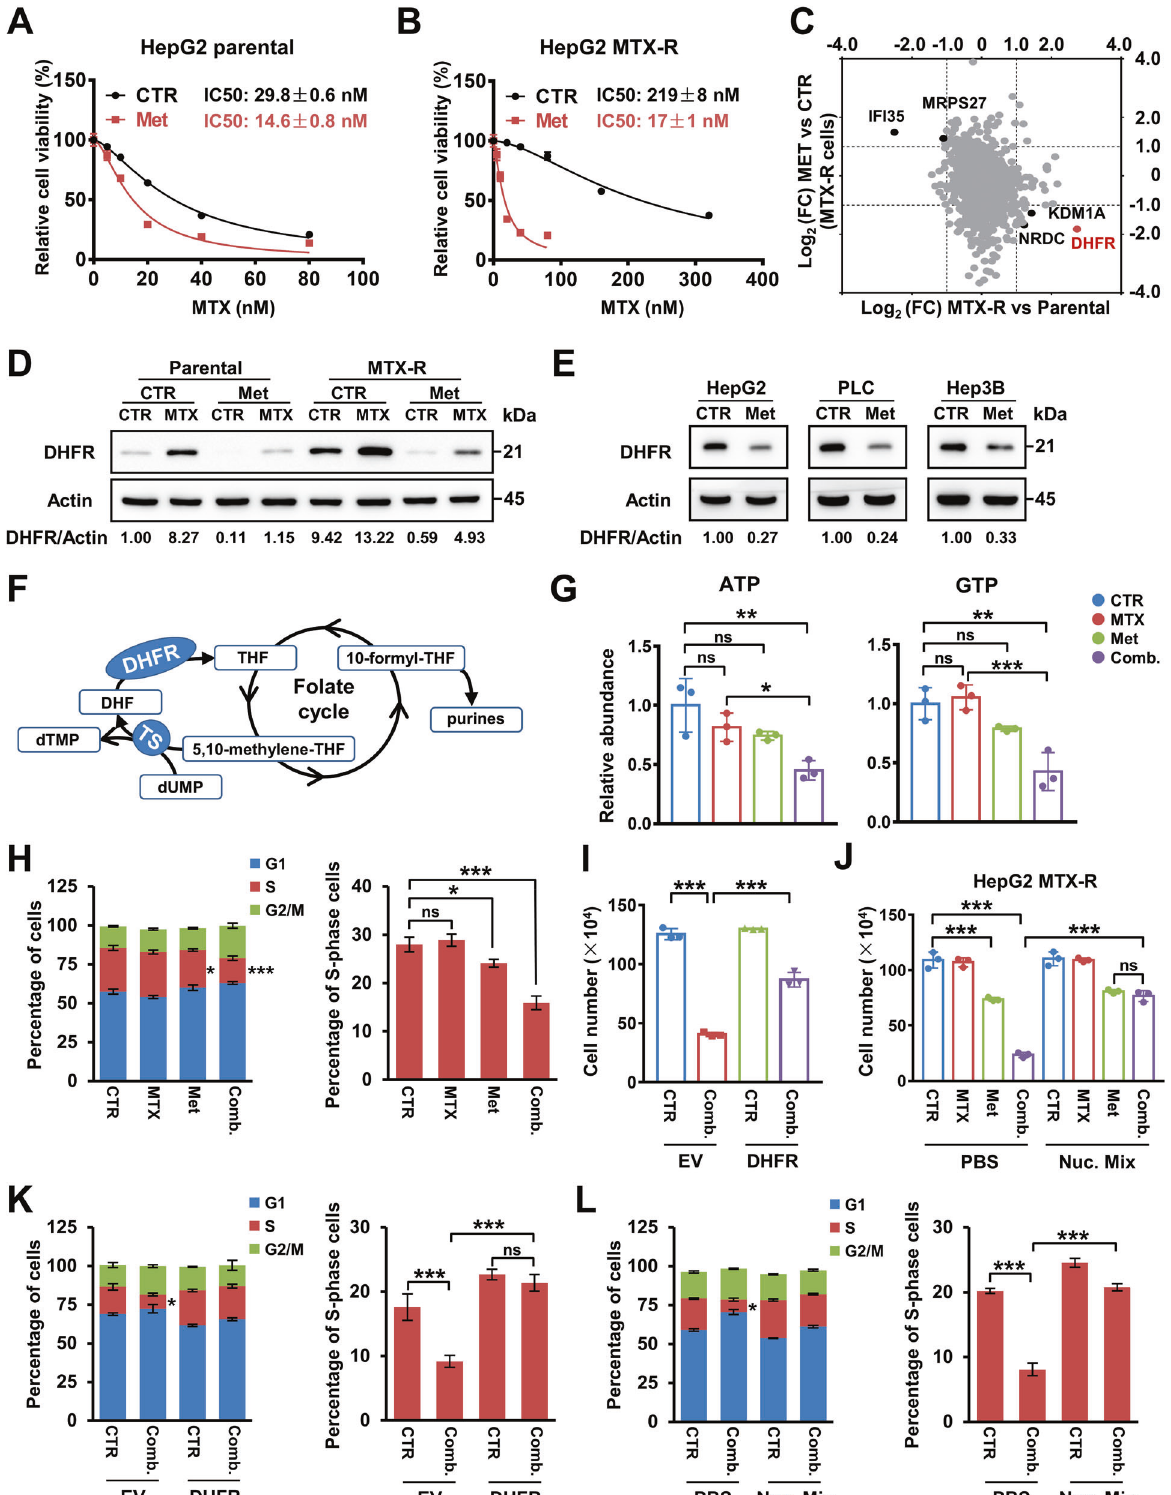
the degradation of exogenous DHFR protein (Fig. 3C and Supplementary Fig. 3C), verifying that metformin downregulates DHFR by accelerating its protein degradation. The proteasome pathway and the lysosomal pathway are two major pathways responsible for protein degradation [28]. Our data showed that proteasome pathway inhibitor MG132 did not affect